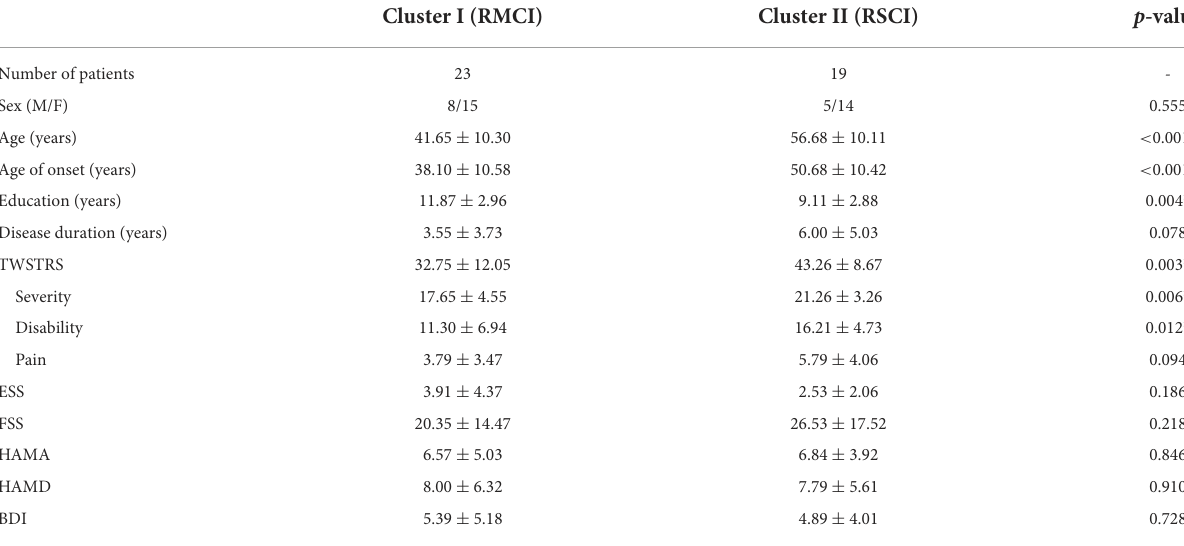
TABLE 6 Demographic and clinical data between two